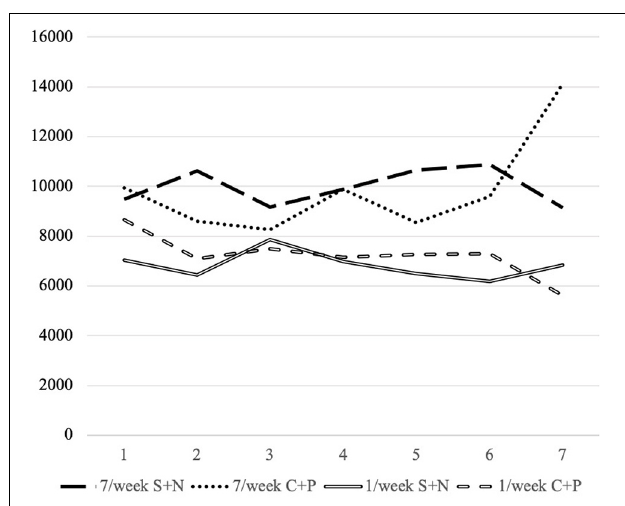
FIGURE 3 | Steps taken weekly via mental simulation